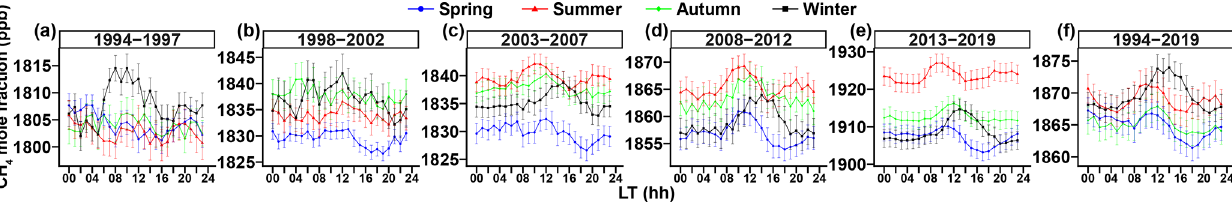
Figure 3. Diurnal CH 4 cycles in different periods from 1994 to 2019 at the WLG station. The lines with different colors represent various seasons. Error bars indicate the 95% confidence intervals.